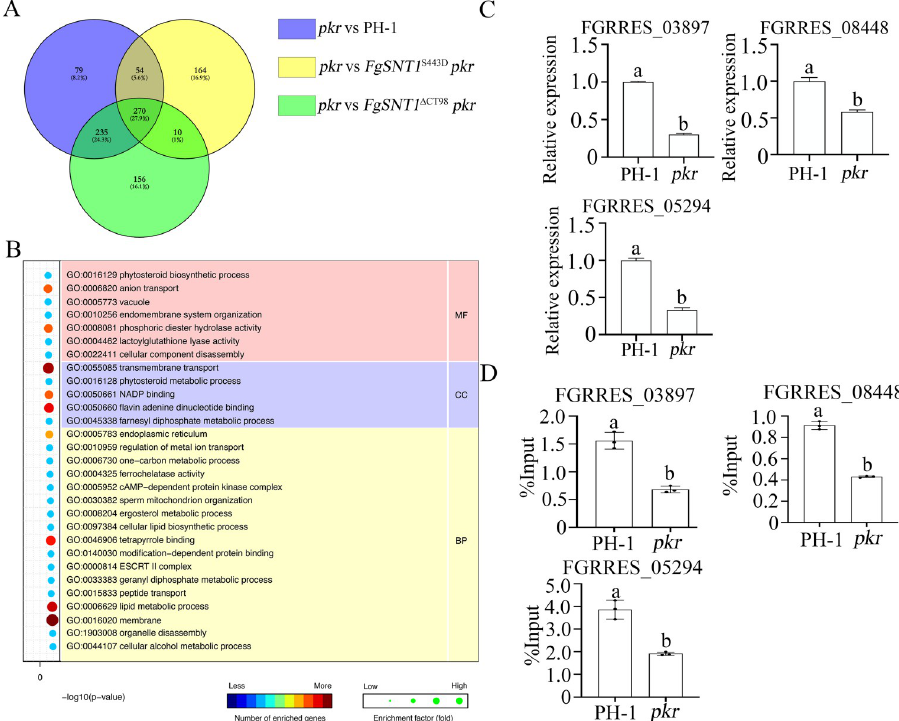
Fig 12. RNA-seq and ChIP-seq analyses with the pkr1 mutant and its transformants expressing FgSNT1 Δ CT98 and FgSNT1 S443D . (A) . A Venn diagram showing the numbers of genes down-regulated (left panel) in the pkr , FgSNT1 Δ CT98 pkr , and FgSNT1 S443D pkr mutants. (B) . GO enrichment analysis of genes down-regulated in the pkr mutant but recovered in expression in the FgSNT1 Δ CT98 pkr and FgSNT1 S443D pkr mutants. (C). The expression levels of FGRRES_08448, FGRRES_03897, and FGRRES_05294 in PH-1 (arbitrarily set to 1) and the pkr mutant were assayed by qRT-PCR. (D) . The abundance of the promoters of marked genes in the input samples (no ChIP) and chromatin fragments immunoprecipitated with the anti-H4ac antibody in ChIP assays with PH-1 and the pkr mutant was assayed by qPCR. Relative abundance (y-axis) is expressed as the percentage of abundance in input samples in immunoprecipitated samples. Different letters (a, b) indicate significant differences based on ANOVA analysis followed by Duncan’s multiple range test (P = 0.05).